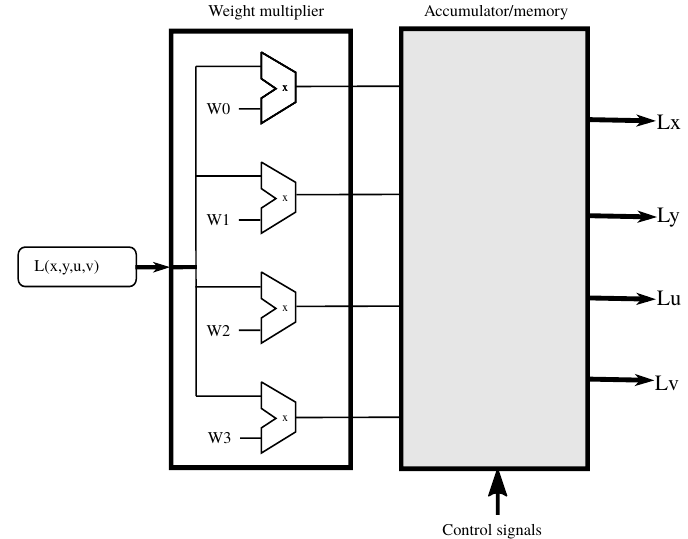
Figure 4. Implementation of weight multipliers for serial